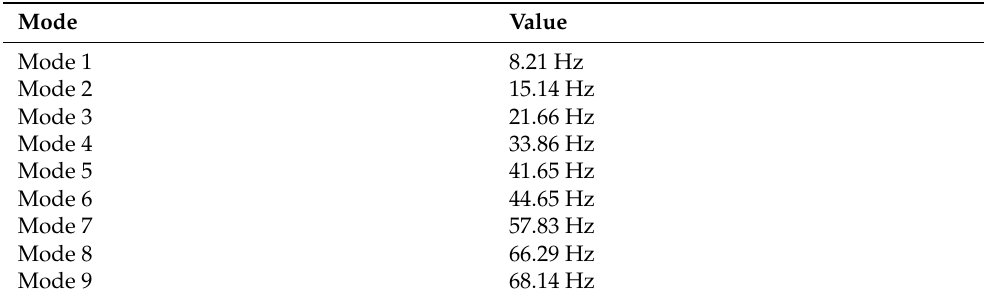
Table 7. Different modes and associated natural frequencies of the structure.